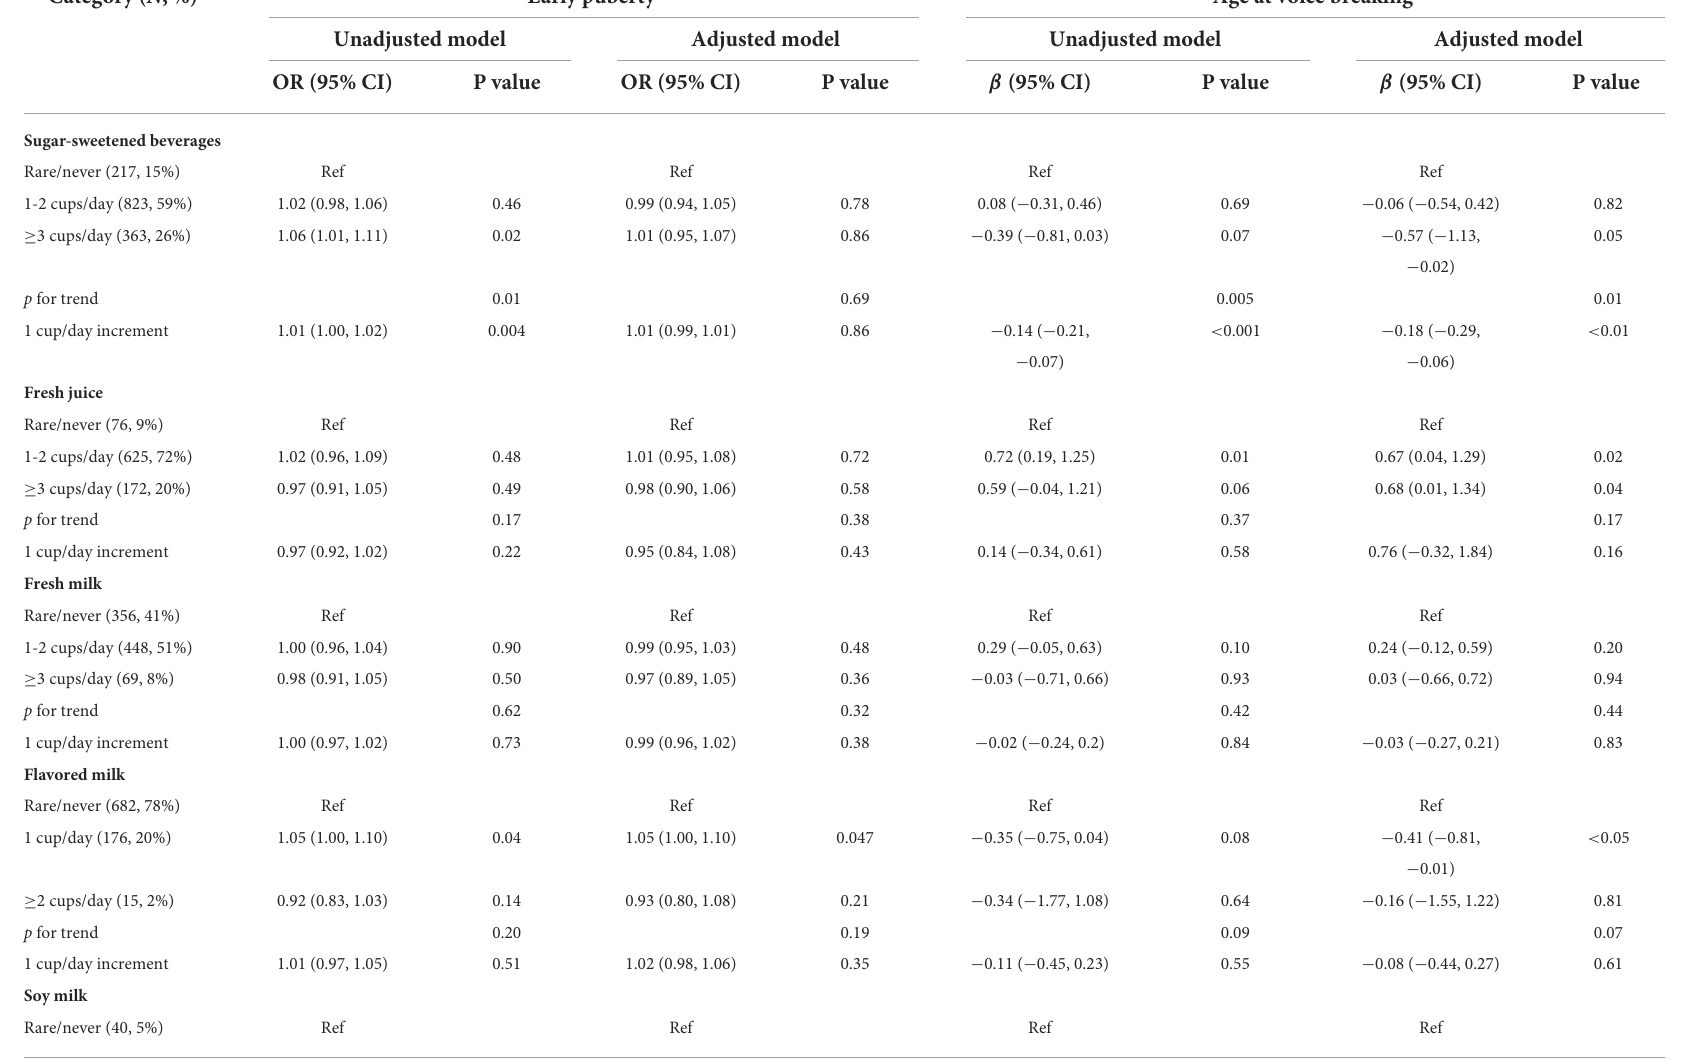
TABLE 2 OR and regression coefficients for the associations between consumption of selected drinks and pubertal outcomes (boys). Category ( N ,